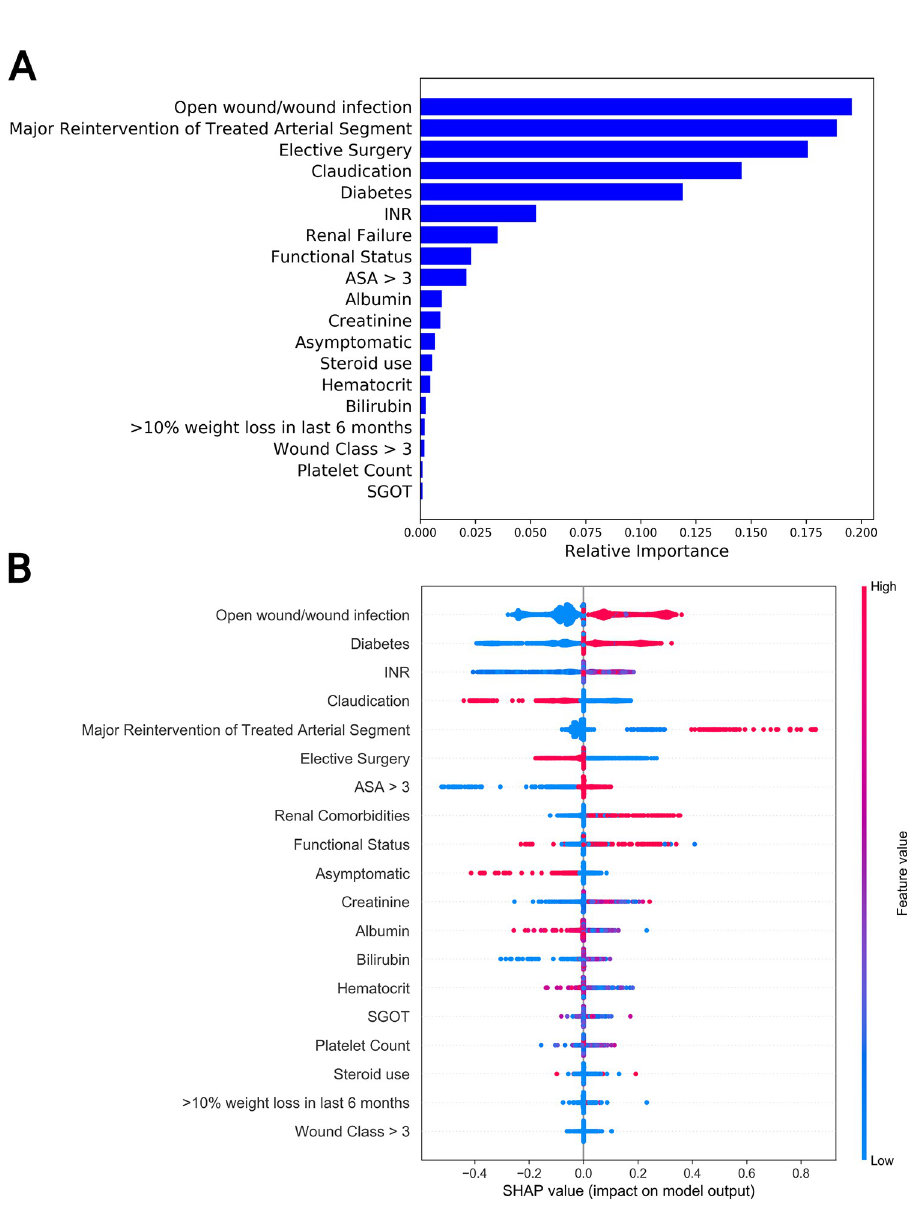
Fig 4. Gini impurity and SHAP scores for unplanned readmission. a) Gini impurity scores for features included in the 30-day unplanned readmission model. Higher values indicate increased effectiveness of features at separating those at risk of 30-day unplanned readmission from those not at risk of 30-day unplanned readmission. b) A Shapley summary plot. Color indicates feature value (red: High, blue: Low) and position along the x-axis indicates magnitude and direction of the feature’ impact on model